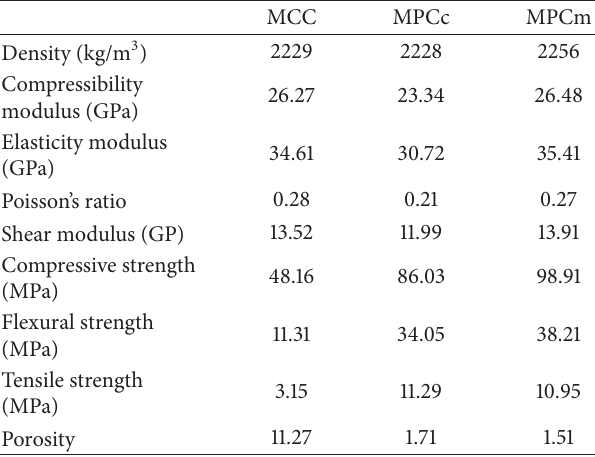
Table 6: Characteristics of MPC and MCC before chemical